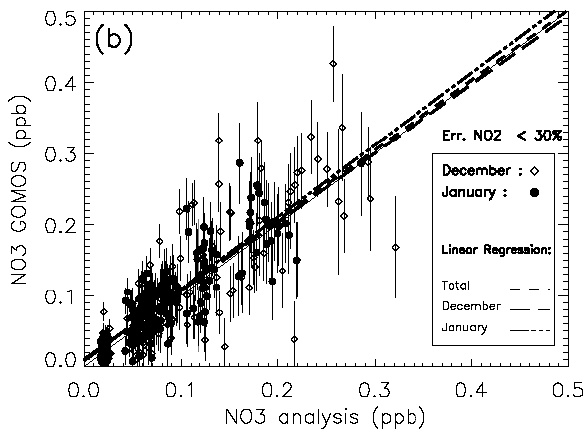
Fig. 35. GOMOS NO 3 measurement as a function of analyzed NO 3 for cases when NO 2 error measurements are less than 30%. NO 3 error measurements are indicated with vertical lines. The linear regressions for the different periods are represented with dashed lines. The 1-to-1 line is represented with a thin black line. The two periods of GOMOS O 3 and NO 2 assimilated data are December 5 to 6, 2002, and January 30 2003,with occultations of the star Beta Carinae (GOMOS star S029, visual magnitude 1.67, temperature 10200 K) in a latitude band 0–1°N for the first period, and 16–17°N for the second period (from Marchand et al., 2004).